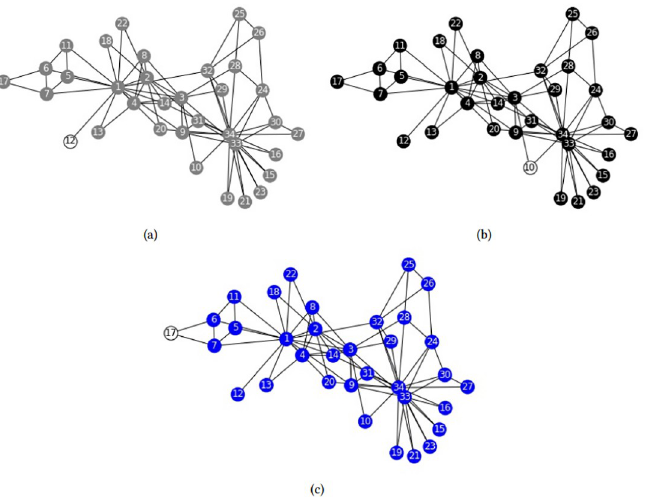
with n = 3. (a) Community 1, (b) Community 2, (c) Sh − Jk c